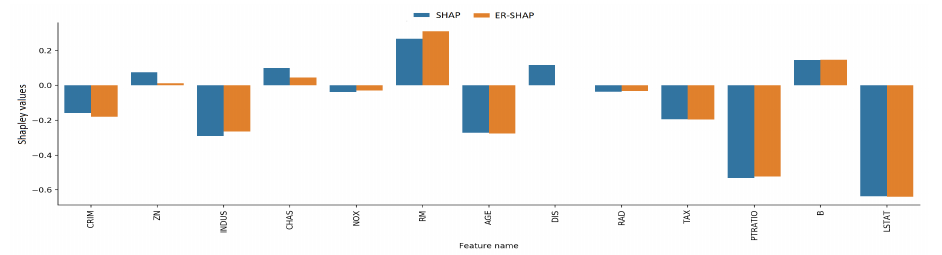
Figure 19. Shapley values obtained by means of SHAP and ERW-SHAP for features of the Boston Housing dataset under condition of using the normal distribution of feature changes with the standard deviation 0.1.